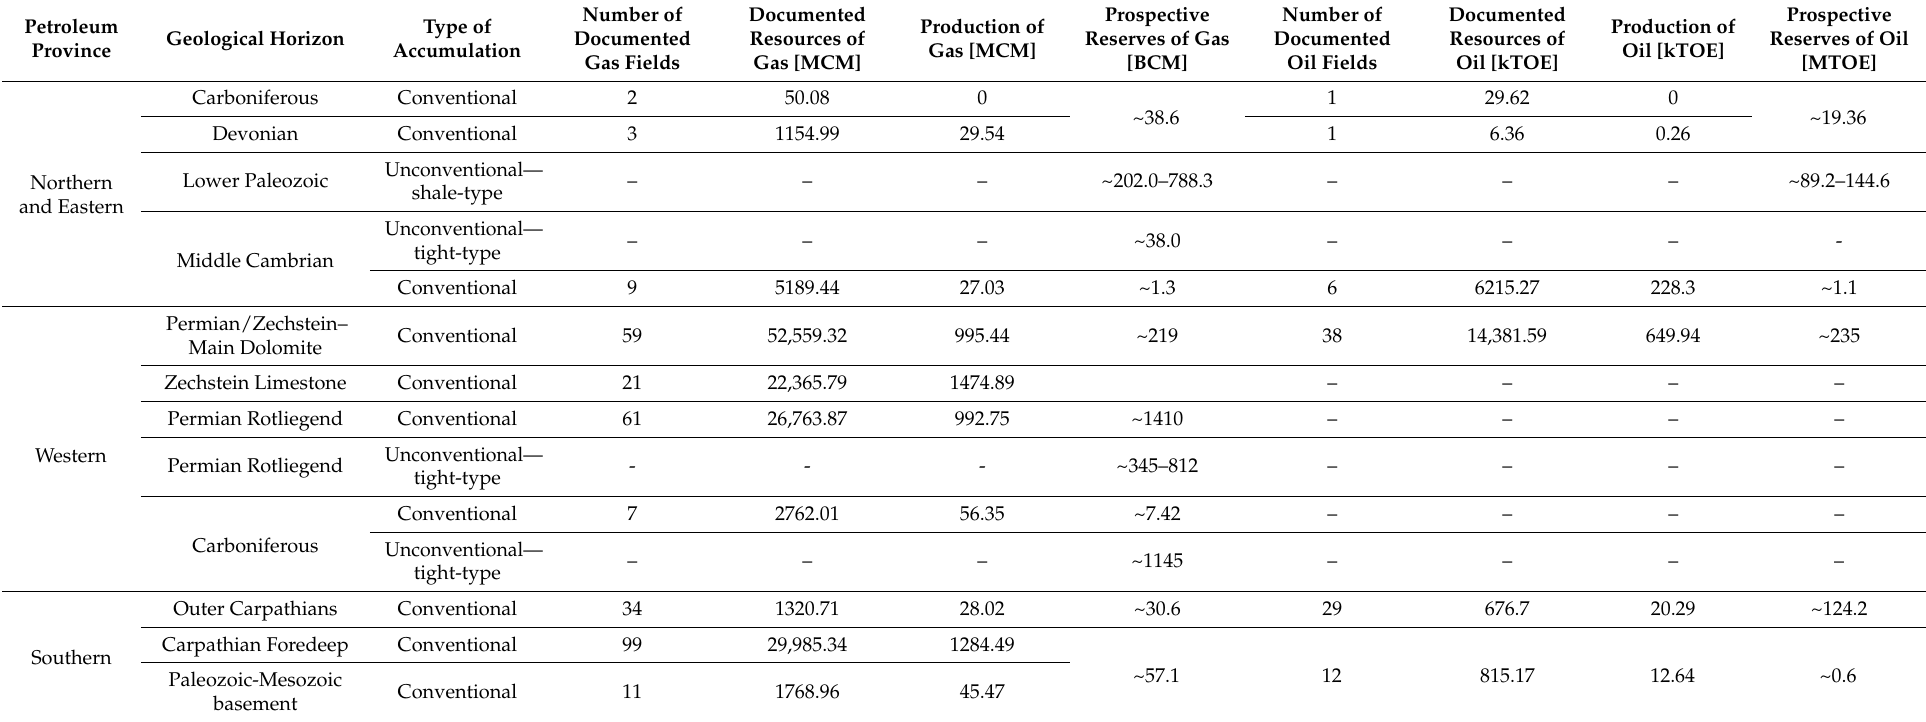
Table 1. Principal geological horizons of crude oil and natural gas occurrences in Poland with several fields, documented resources, production, and prospective conventional and unconventional reserves (see Figures 3 and 4)